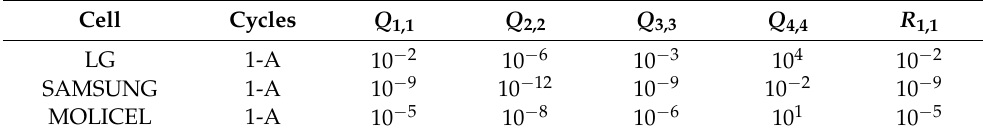
Table 5. Coefficients of the covariance matrices found by the genetic algorithm.